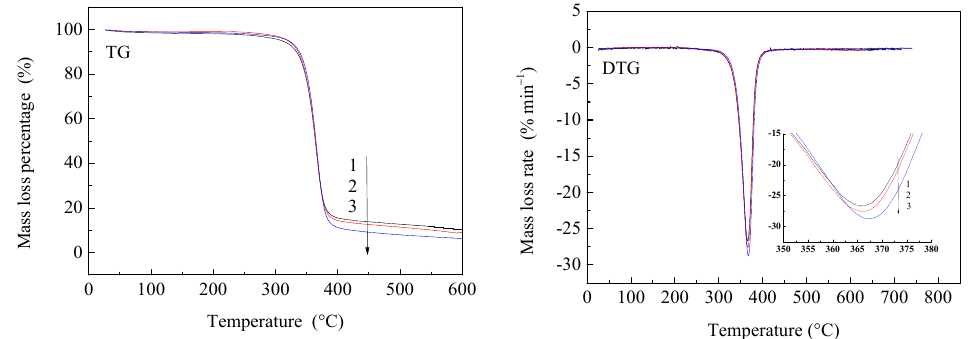
Figure 10. TG-DTG curve of diacetate fiber (1) Untreated diacetate fiber; (2) Diacetate fiber treated by SCF-CO 2 at 80 °C, 20 MPa, 90 min; (3) Impregnation of diacetate fiber with resveratrol in SCF- CO 2 at 80 °C, 20 MPa, 90 min. 80 ◦ C, 20 MPa, 90 min.